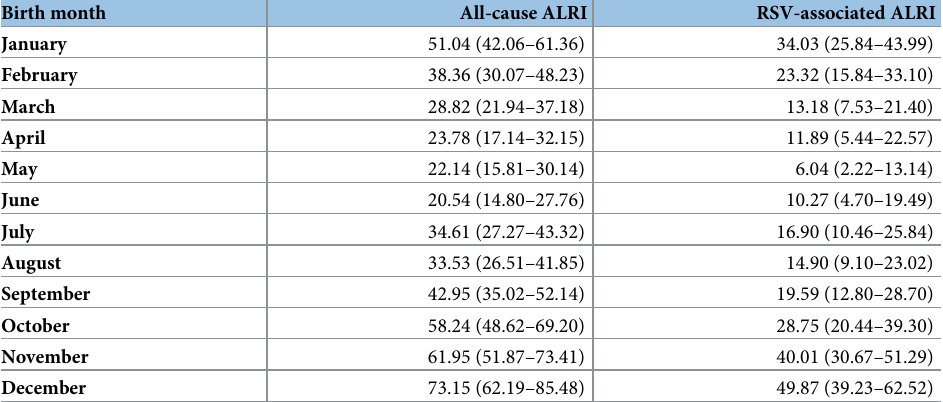
Table 2. Annual hospitalisation rate (per thousand live births) in the first year of life by birth month in 2014–19. Birth